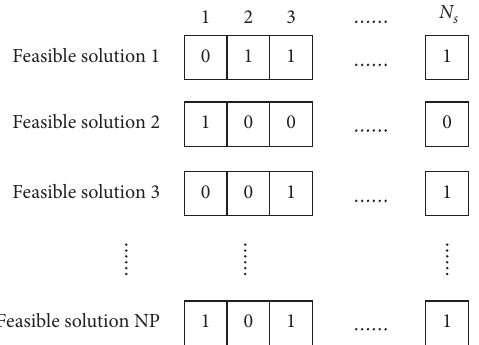
Figure 6: Schematic diagram of the feasible solution of the IBABC algorithm. Table 1: Pseudocode for calculating COV( S ) of K -covered network coverage rate based on probability p A